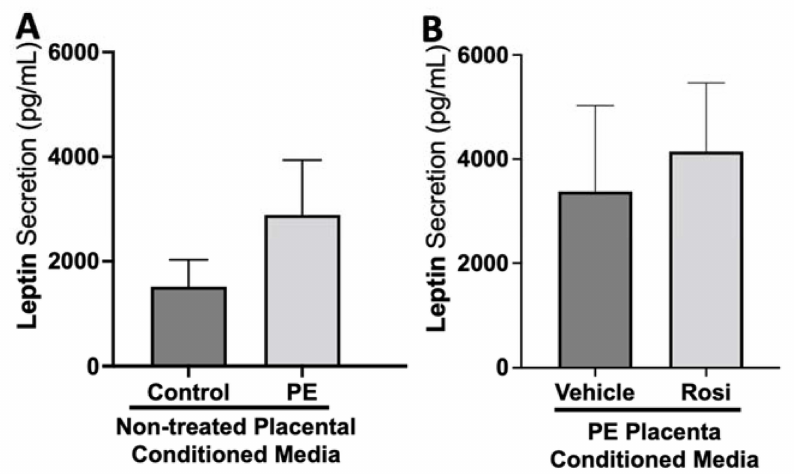
Figure 9. There are no significant changes in Leptin secretion between healthy and preeclamptic placentas with or without drug treatment. Secretion of Leptin was measured via Luminex assay from conditioned media from non-treated control and preeclamptic (PE) placentas ( A ) and vehicle- or Rosiglitazone (Rosi)-treated PE placentas ( B ). Although there was an increasing trend of Leptin secretion from PE placentas, this was not statistically different from the control placentas ( A , n > 10). There were no significant changes in Leptin secretion between vehicle and Rosi-treated PE placentas ( B , n = 14). (Protein secretion was measured by a Luminex assay where experimental values were determined relative to a standard curve. Statistical analysis was performed by student’s t -test to determine significant differences between groups, bar plots and data reported are reported as mean pg/mL values ±